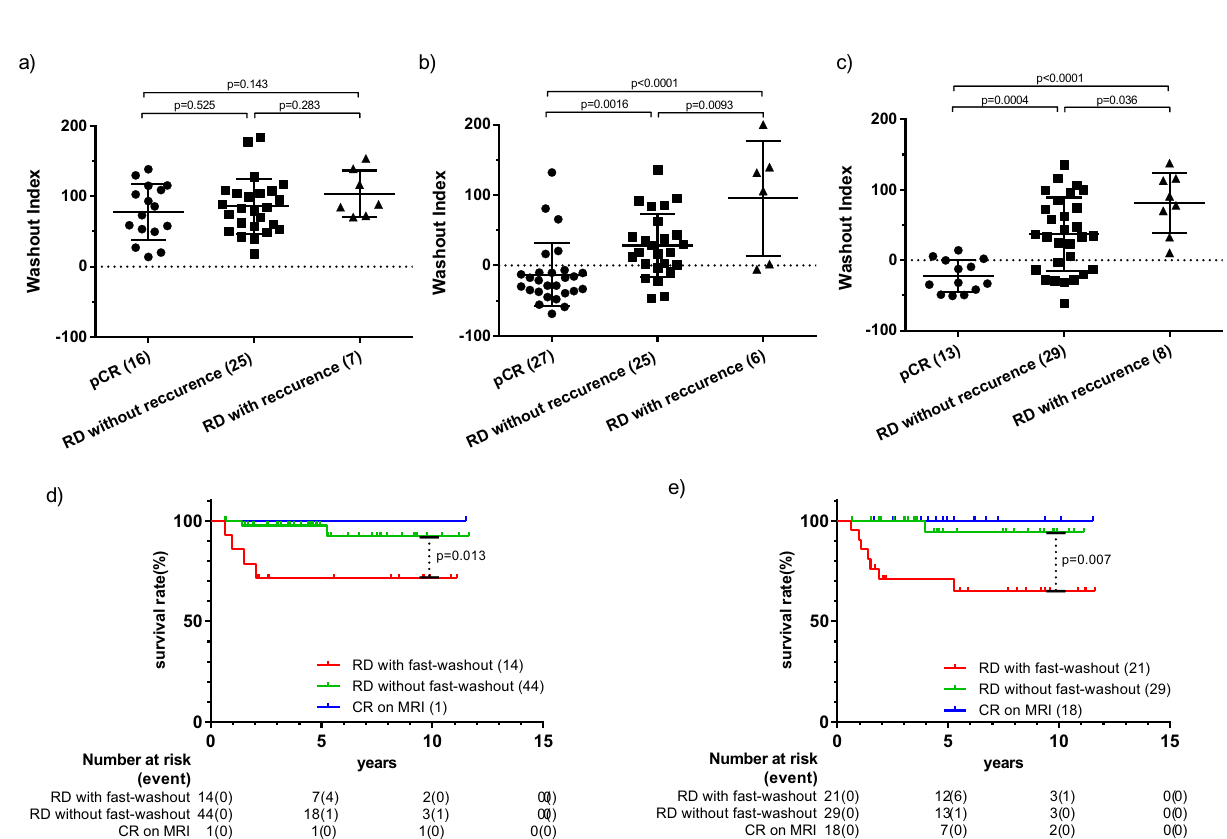
Figure 3. The change of WI values through preoperative chemotherapy and distant disease-free survival (DDFS) curves by the presence of RD with/without fast-washout curve type. The WI values at three time points (MRI pre , MRI mid and MRI post ) were shown ( a-c ). The number of total included lesions was 48 in MRI pre ( a ), 58 in MRI mid ( b ) and 50 in MRI post ( c ). The patients were divided into three groups according to whether the postoperative tumour was pCR, with RD without recurrence or RD with distant-recurrence. Each plot represented the WI of each lesion, showing the mean and standard deviation for each group. Each group was compared by Student t-test. DDFS curves were shown by CR on MRI, the presence of RD with a fast-washout curve type and RD with other curve types at MRI mid ( d ) and MRI post ( e ). Each survival curve was compared by the log-rank